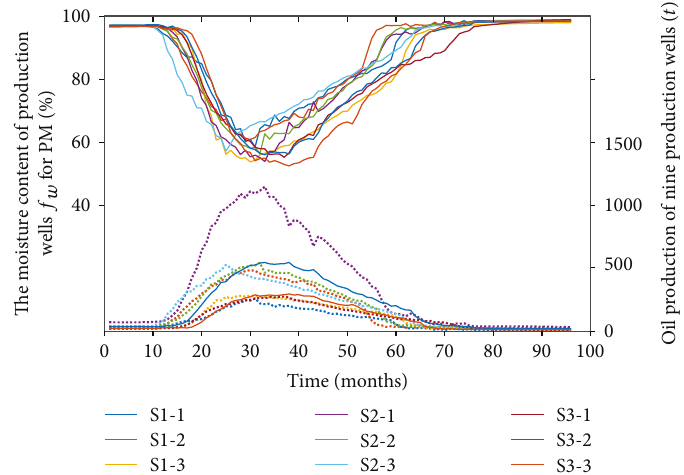
Figure 12: The moisture content and oil production of production wells for PM.